Question: State the chart type depicted above.
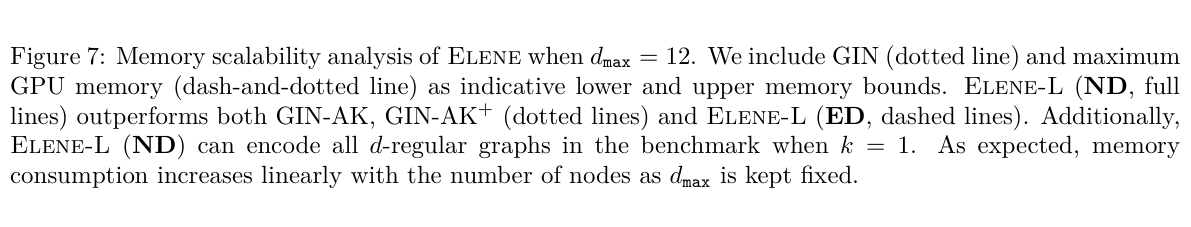
Answer: line